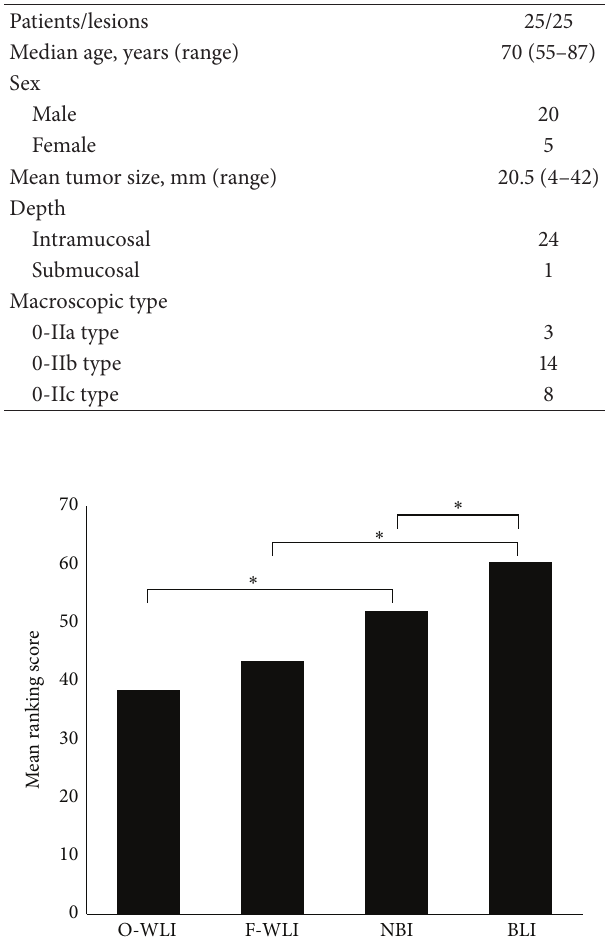
Figure 4: Subjective evaluation. Statistical comparison of the ranking score of O-WLI, F-WLI, NBI, and BLI-bright images for qualityofESCCvisualization(Wilcoxonsigned-ranktest).Numbers above each row denote the numbers of ESCCs. ∗ 𝑃 < 0.01 .